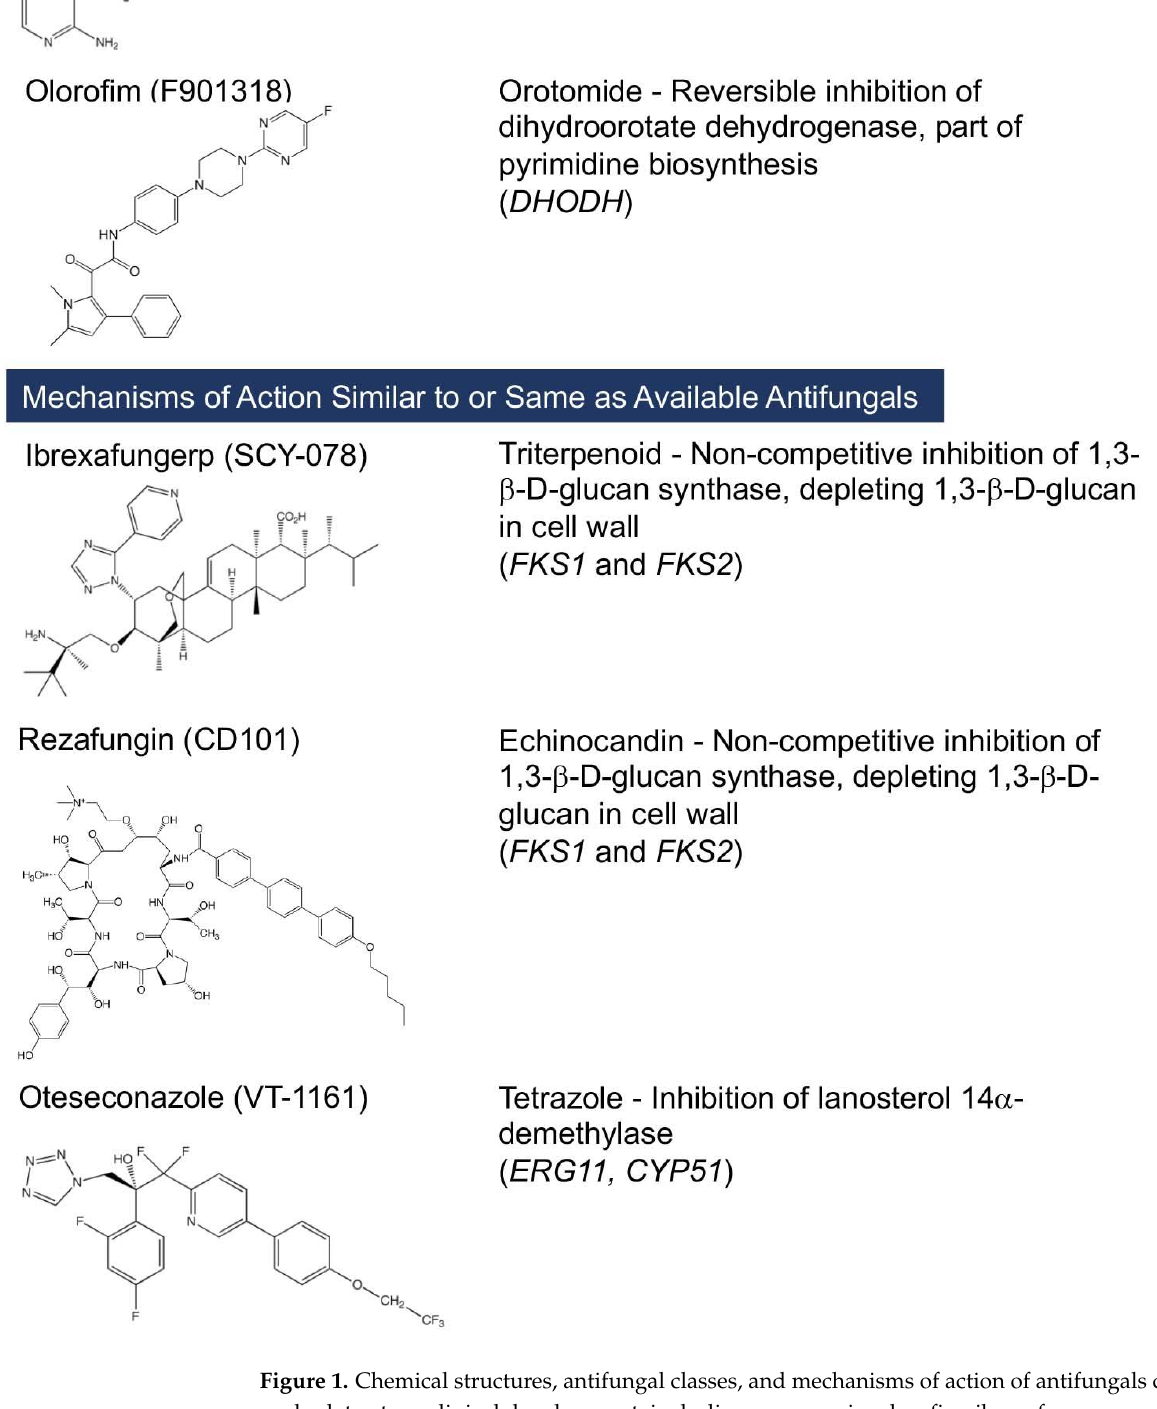
Figure 1. Chemical structures, antifungal classes, and mechanisms of action of antifungals currently under late-stage clinical development, including manogepix, olorofim, ibrexafungerp, rezafungin, and oteseconazole.